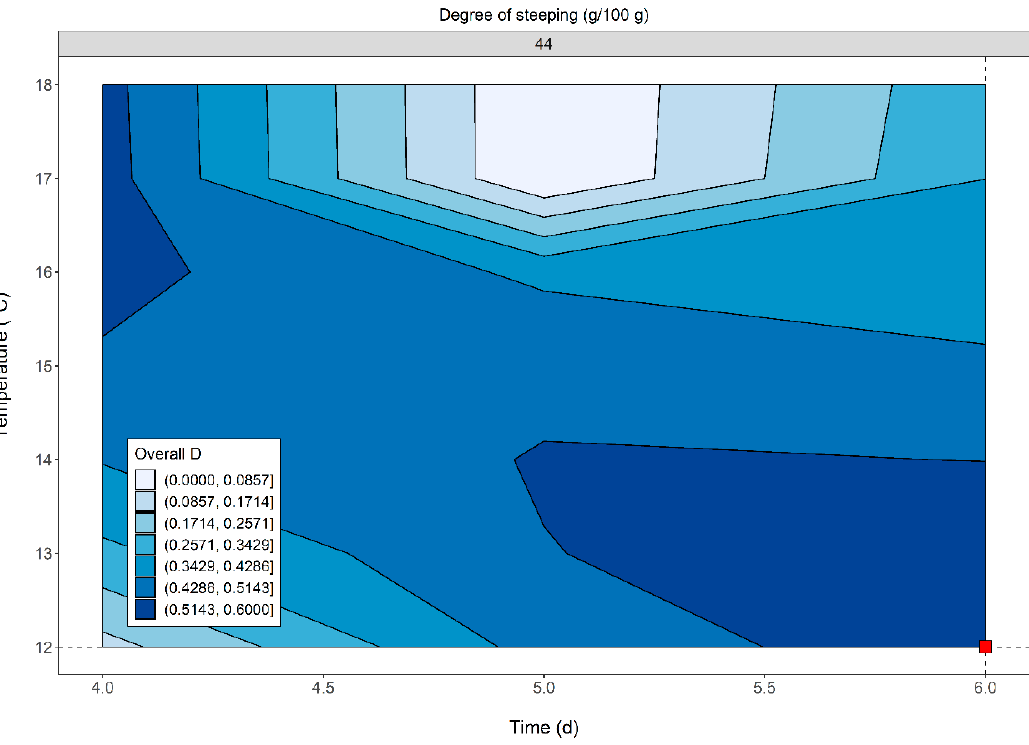
Figure 6. Contour plot of the overall desirability D. Color shades refer to specific D ranges: from light to dark blue, D increases. The dotted lines meet at the highest computed overall desirability value D (0.564), denoted by the red square.